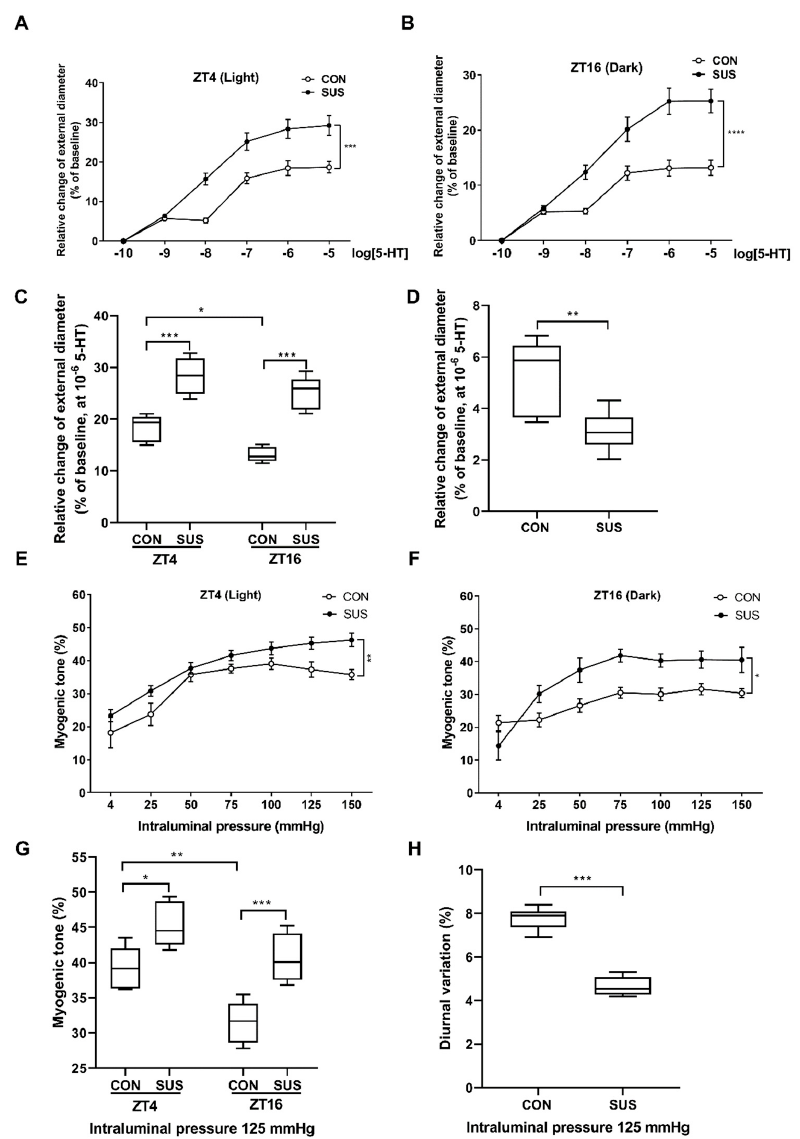
Figure 1. Diurnal rhythm of vasoconstrictor responsiveness to 5-HT and myogenic tone in middle cerebral arteries isolated from CON and SUS rats. The concentration-response curves were determined by the cumulative superfusion of 5-hydroxytryptamine (5-HT, 10 − 10 to 10 − 5 M) in middle cerebral arteries isolated from CON and SUS rats at ZT4 ( A ) and ZT16 ( B ), respectively. The contractile responses in response to 10 − 6 M 5-HT were markedly increased at both ZT4 and ZT16 in SUS rats as compared with that in CON rats ( C ). The diurnal variation in vasoconstrictor responsiveness (the di ff erence value between ZT4 and ZT16 level) significantly decreased in SUS rats as compared with that in CON rats ( D ). The myogenic tone of middle cerebral arteries isolated from CON and SUS rats was calculated when intraluminal pressure ranging from 4 to 150 mmHg at ZT4 ( E ) and ZT16 ( F ), respectively. The myogenic tone markedly increased at both ZT4 and ZT16 in SUS rats as compared with that in CON rats when intraluminal pressure was 125 mmHg ( G ). The diurnal variation in myogenic tone (the di ff erence value between ZT4 and ZT16 level) significantly decreased in SUS rats as compared with that in CON rats ( H ). Data are presented as box plots and 5th and 95th percentiles. n = 6, t -test, * p < 0.05, ** p < 0.01, *** p < 0.001. CON: 28-day simultaneous control rats; SUS: 28-day tail-suspended